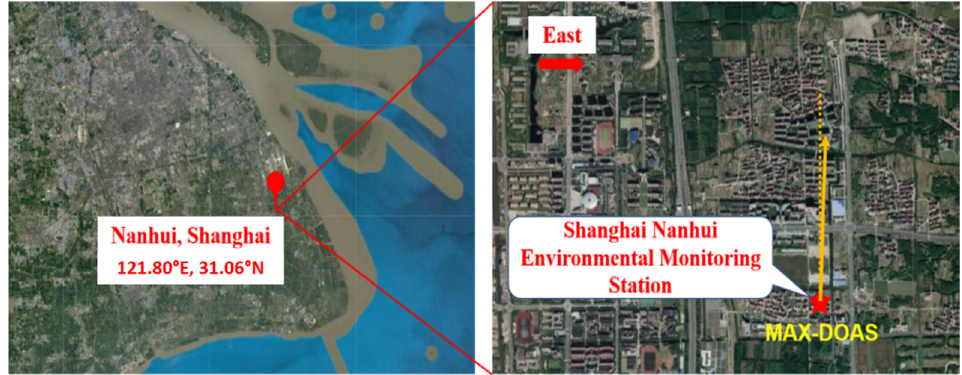
Figure 1. The region surrounding the measurement station (31.05°N, 121.81°E) is shown by the topography map (Google Maps). The arrow points towards the direction of the telescope of the Multiple AXis Differential Optical Absorption Spectroscopy (MAX-DOAS) instrument.